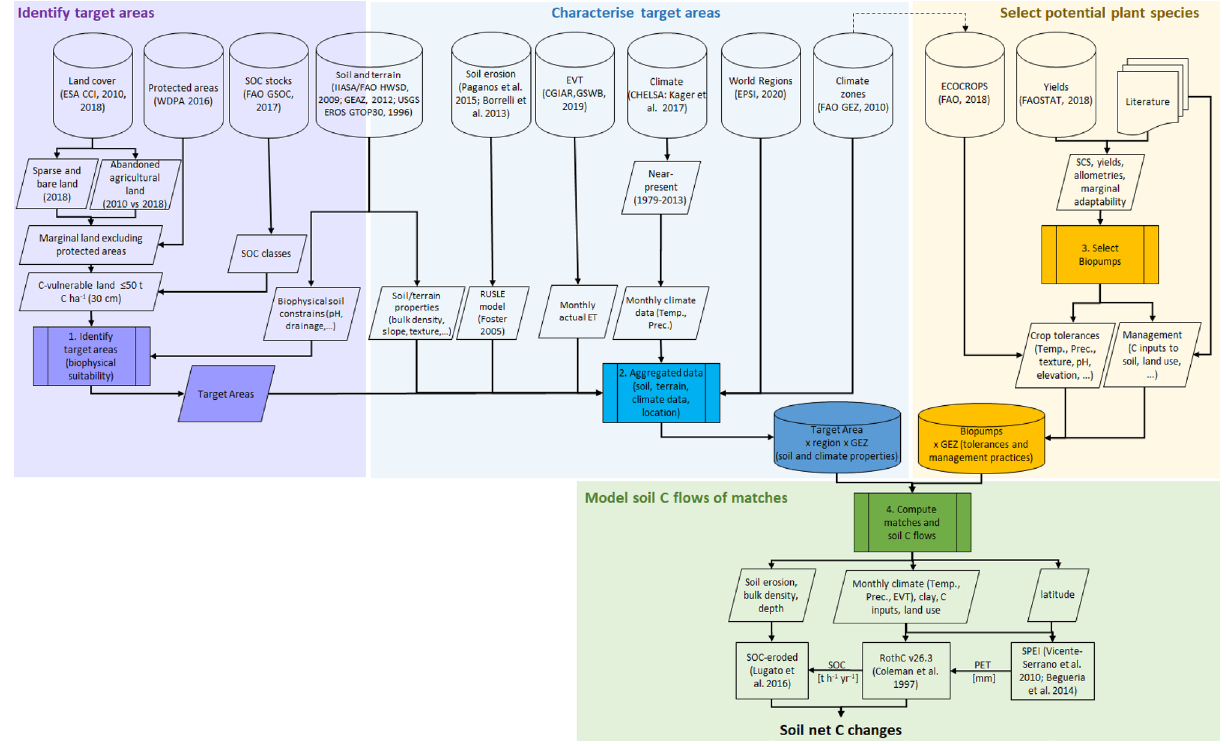
Figure 4. Stepwise framework and data sources for our case study. Temp. temperature, Prec. Precipitation, EVT evapotranspiration, SPEI standardised precipitation evapotranspiration index, PET potential evapotranspiration, SOC soil organic